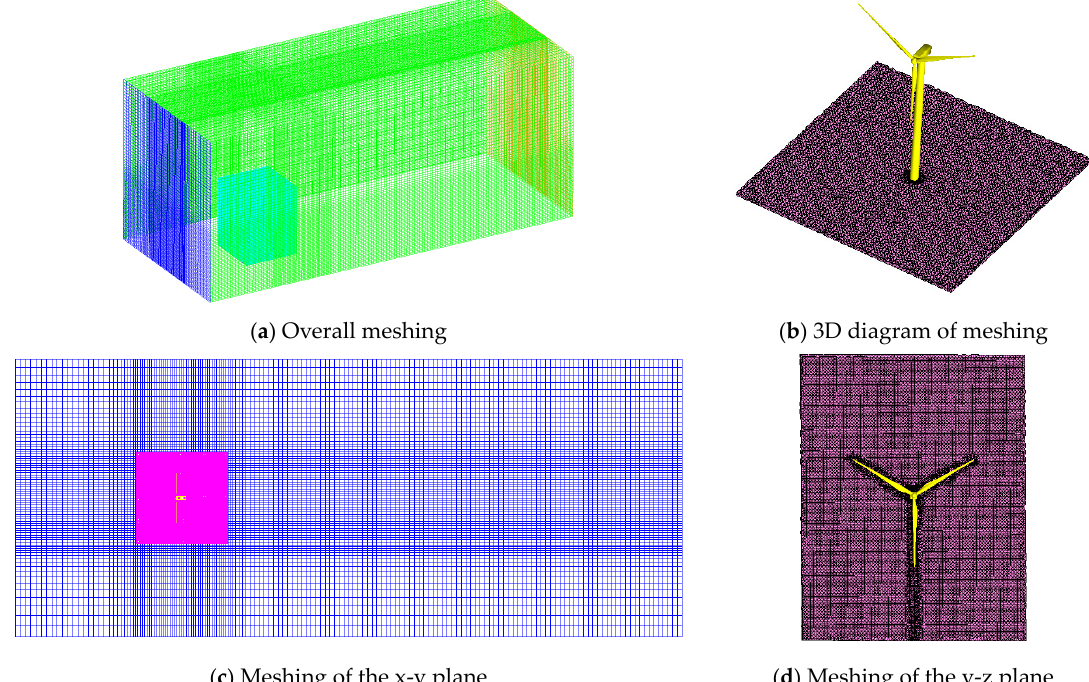
Figure 8. Computational domain and meshing schemes.